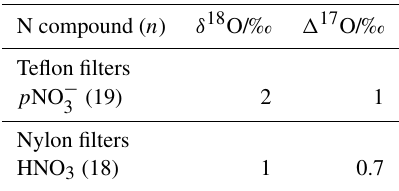
Table 2. Isotopic reproducibility (modified median absolute devia- tion) established using two to four parallel active CAPMoN sam- pling set-ups in seven separate sampling periods, resulting in ( n ) total